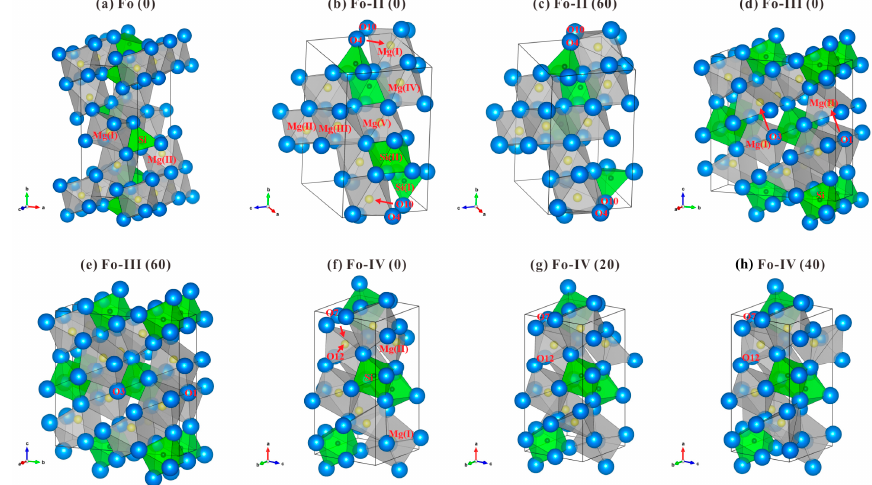
Figure 1. Optimized crystallographic structures of Fo at 0 GPa ( a ); Fo-II at 0 GPa ( b ) and 60 GPa ( c ); Fo-III at 0 GPa ( d ) and at 60 GPa ( e ); and Fo-IV at 0 GPa ( f ), at 20 GPa ( g ) and at 40 GPa ( h ). All structures were calculated at 0 K. The Si-O polyhedra are shown in light green and Mg-O polyhedra are shown in light grey. The Mg, Si and O atoms are represented by yellow balls, black balls and blue balls, respectively. Number in the parenthesis following the phase is pressure (GPa). Arrows in ( b , d , f ) indicate the moving directions of some particular O atoms, which lead to the formation of the corresponding structures at higher pressures. For the atomic labels and parameters see Supplementary Tables S1-S8. Table 3. Comparison of unit-cell parameters for Fo, Fo-II, Fo-III and Fo-IV. Phase